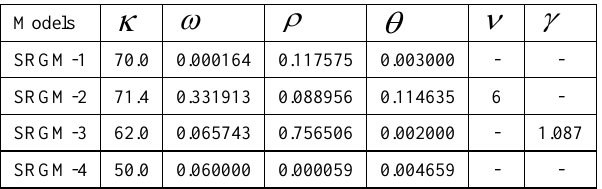
Table 1. Estimated results for dataset 1